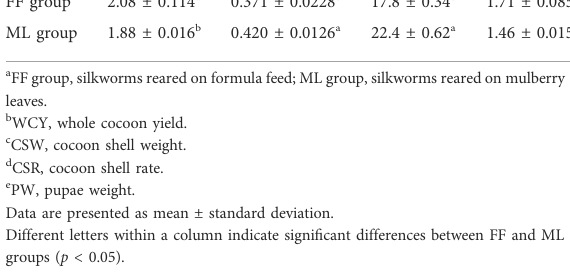
TABLE 1 The cocoon yield performance of silkworms reared on formula feed or mulberry leaves. Treat a WCY b , g CSW c , g